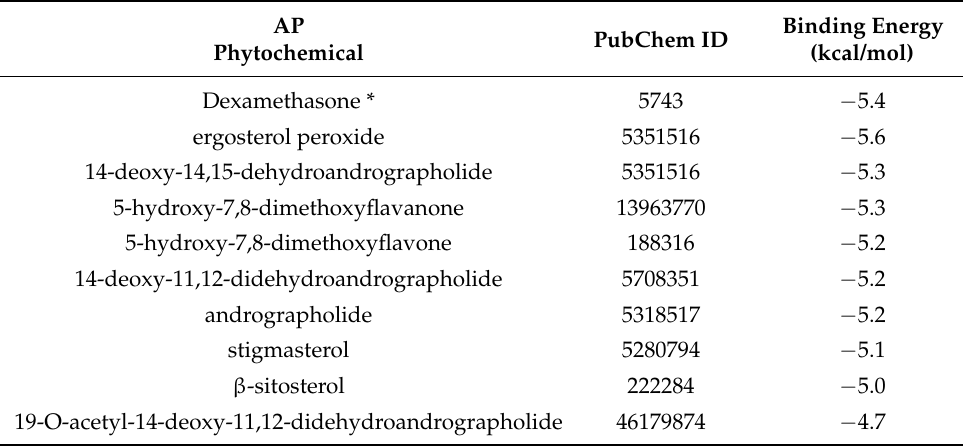
Table 6. Binding energy results of dexamethasone and phytochemicals of Andrographis paniculata with NF- κ B